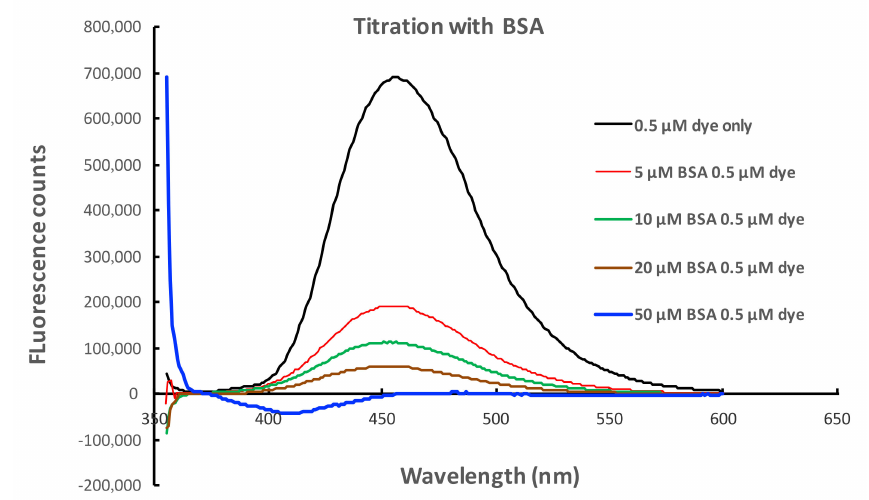
Figure 5. Quenching of 4-phenyl-1,8-naphthalimide by BSA. The fluorescence spectra with BSA samples were derived after subtraction of that of BSA of corresponding